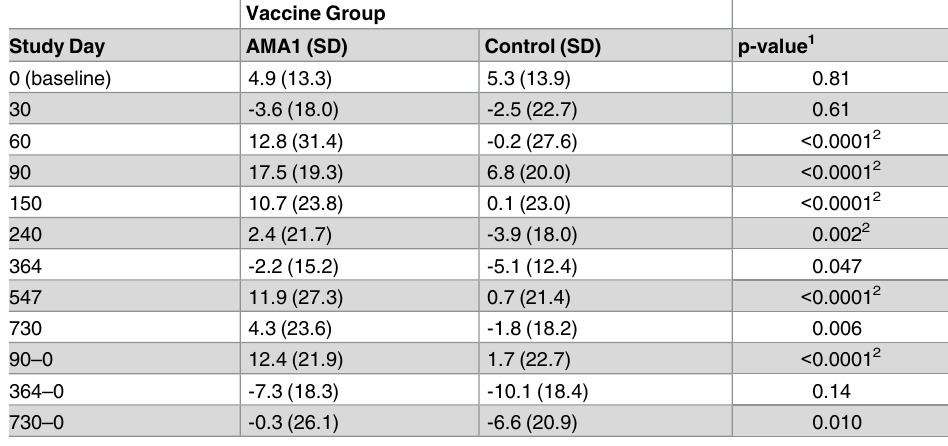
Table 1. Mean 3D7 growth inhibition assay result, and change from baseline to 30 days after last vac- cination and one and two years after enrollment, with standard deviation (SD), by vaccine group.